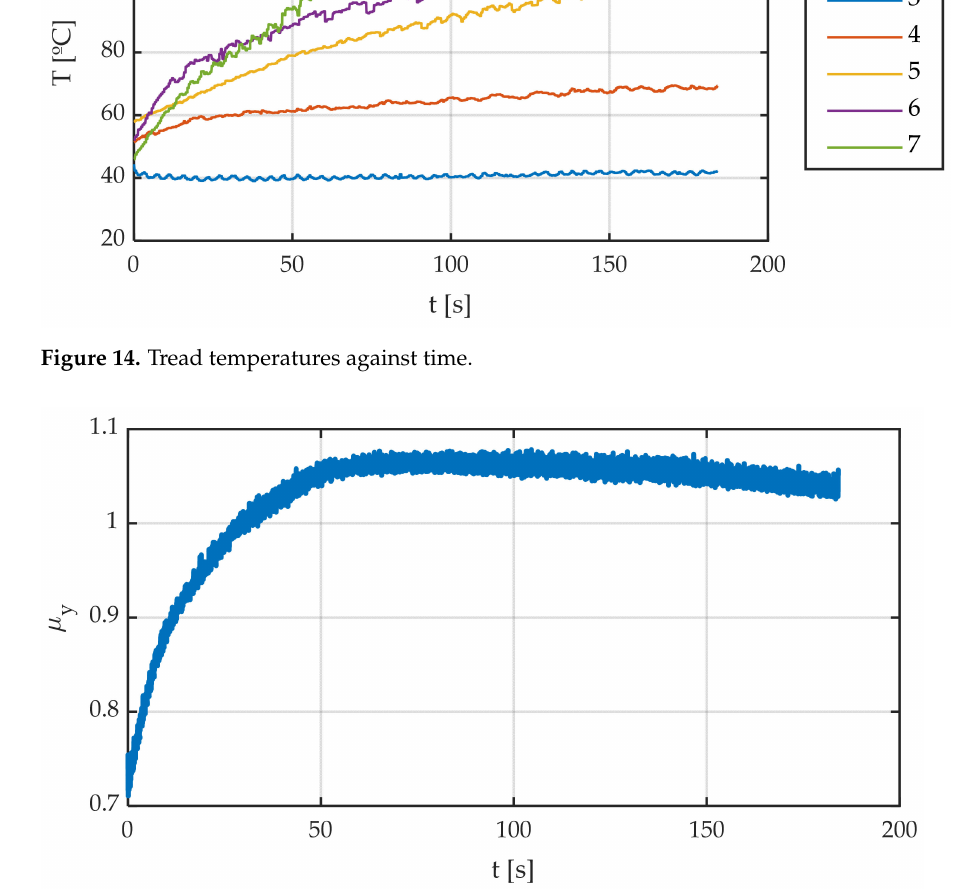
Figure 15. Friction coefficient against